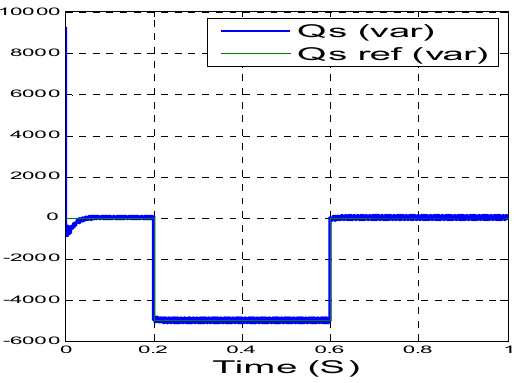
Figure 14. Active power stator.